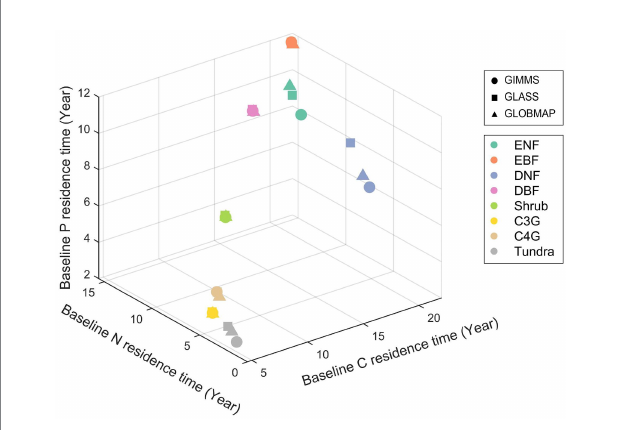
FIGURE 4 Comparison of baseline carbon, nitrogen and phosphorus residence time among different biomes with a three-dimensional scatter plot for each simulation. Abbreviations of biomes are given in Figure